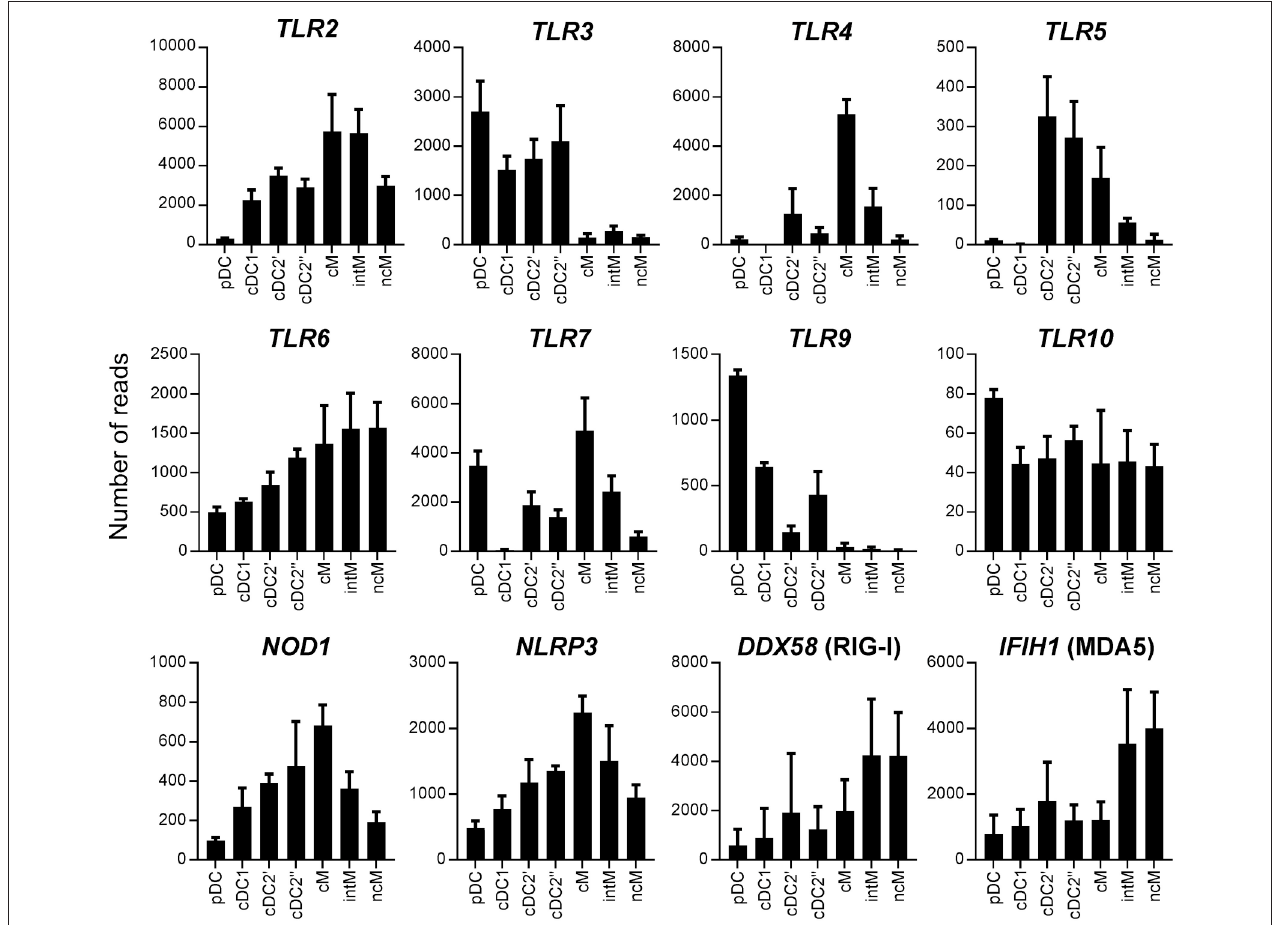
FIGURE 7 | Transcription of pattern recognition receptor (PRR) genes. High-throughput sequencing was performed on RNA isolated from sorted DC and monocyte subsets. Mean number of normalized reads and SD is shown for three animals and selected PRR.